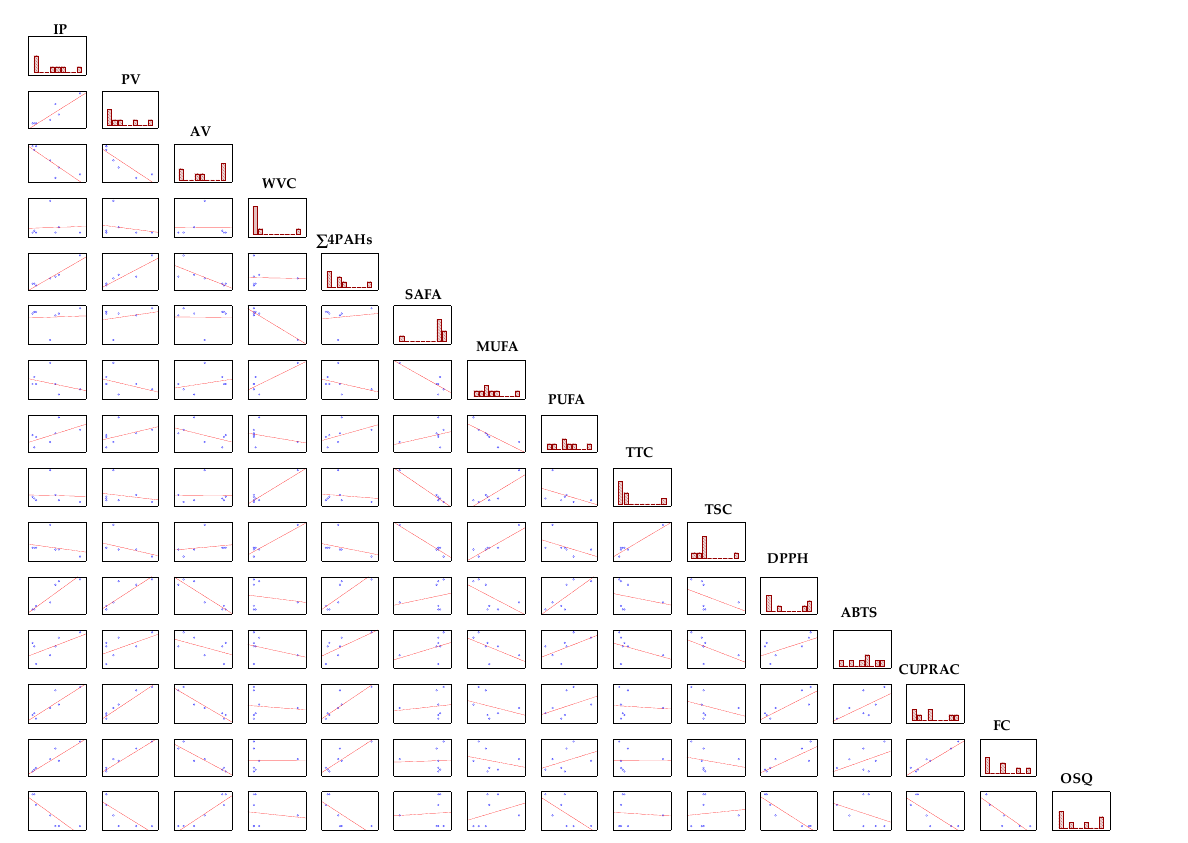
Figure 3. Correlation matrix between the chemical parameters and overall sensory quality levels of cold-pressed black cumin oils.